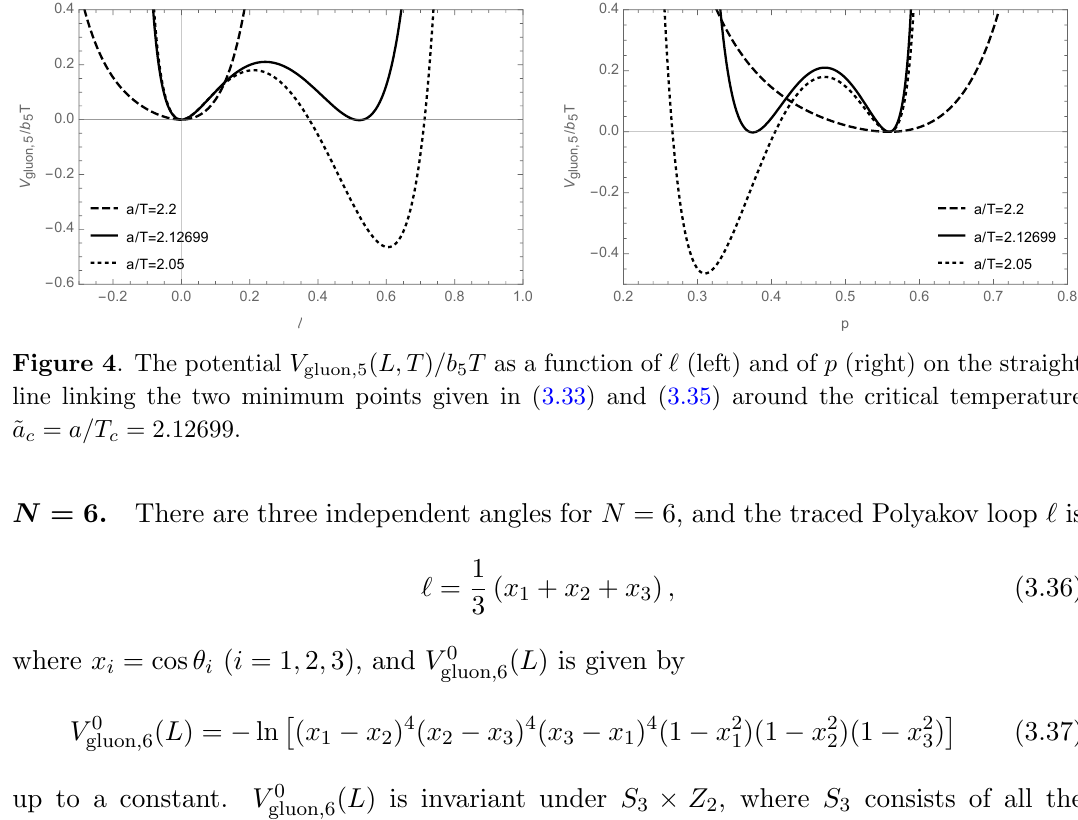
Figure 3 . The contour plot of the potential V gluon ; 5 ( L; T ) =b 5 T at ~ a c = a=T c = 2 : 12699. The green linear line links the two degenerated vacua (3.28) and (3.29) shown by the red points. The shape of the potential as a function of ‘ or p on the linear line corresponds to the black solid-line in (cid:12)gure 4.